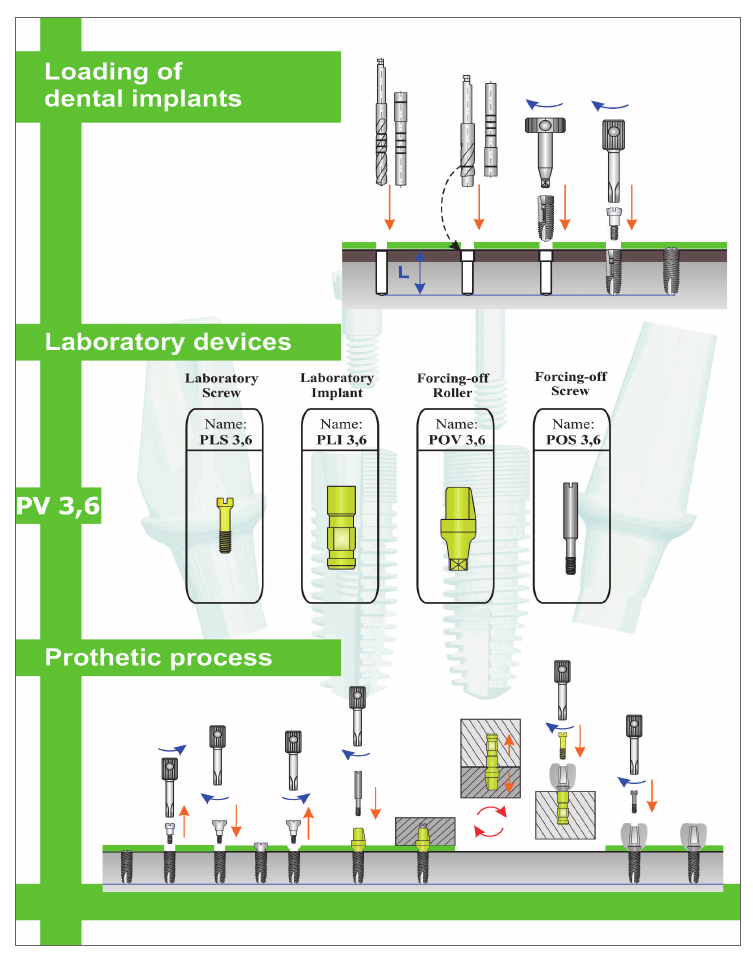
Fig. 6. Implantation protocol in the system PV